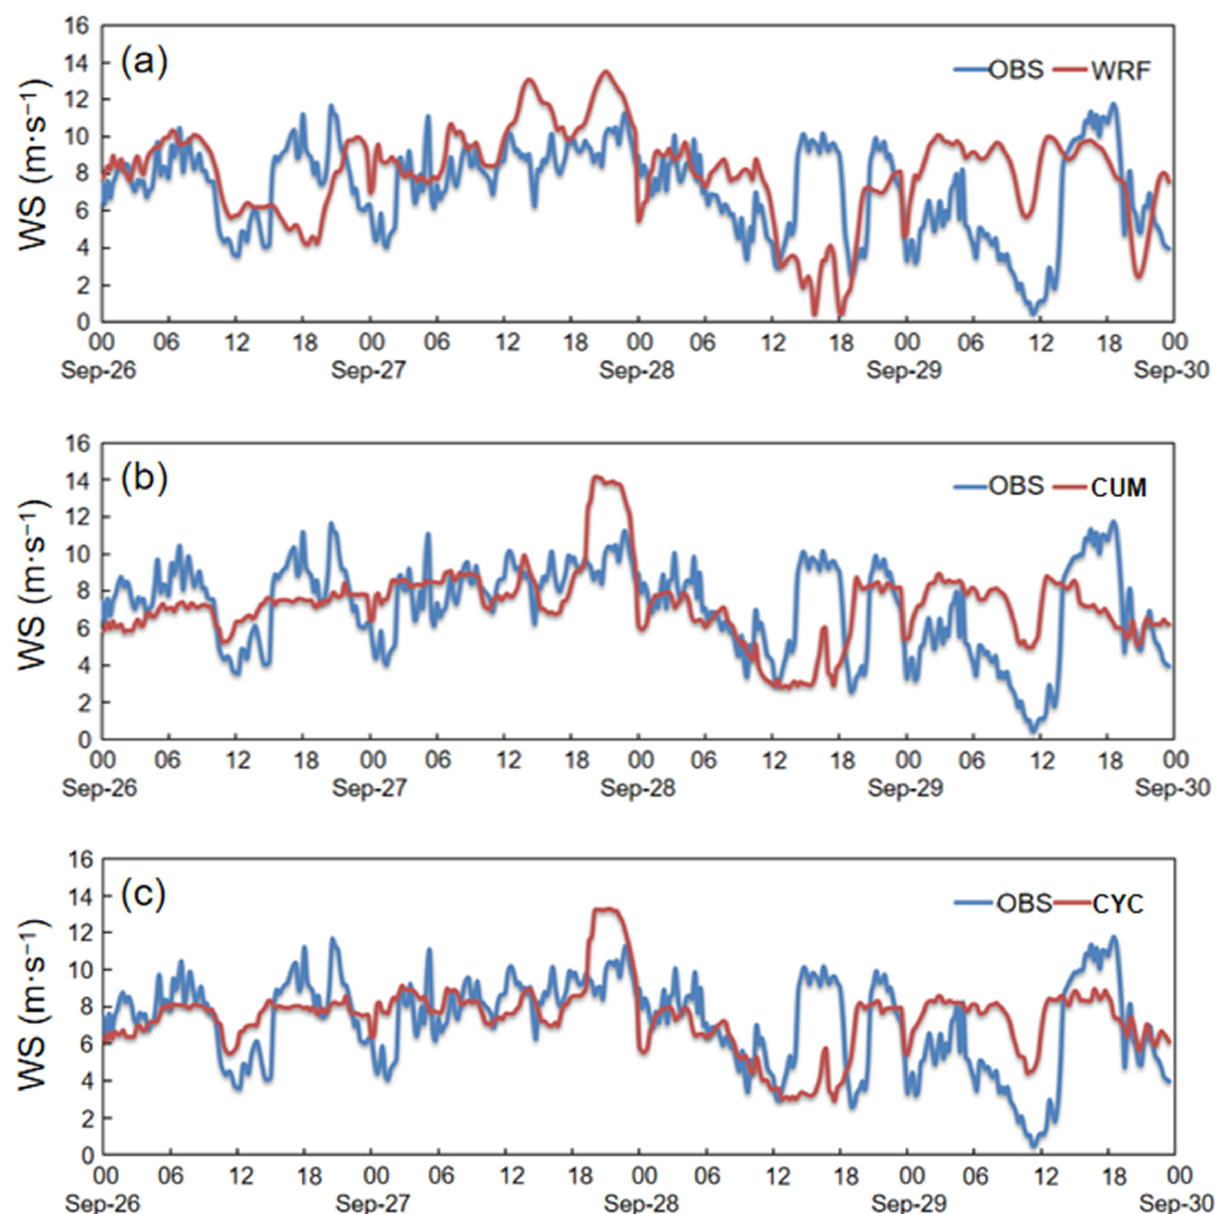
Figure 8. ( a ) Turbine-observed (OBS) and WRF-simulated wind speed (WS, m/s); ( b ) turbine observed (OBS) and CatBoost_CUM-predicted wind speed (WS, m/s); ( c ) turbine observed (OBS) and CatBoost_CYC-predicted wind speed (WS, m/s). Table 3. Comparison of root mean square error (RMSE) between the simulated wind speed by WRF model (WRF_RMSE), CatBoost cumulative learning (CUM_RMSE), CatBoost cyclic learning (CYC_RMSE), and Average Variance–Trend (AVT_RMSE) during 26–29 September.